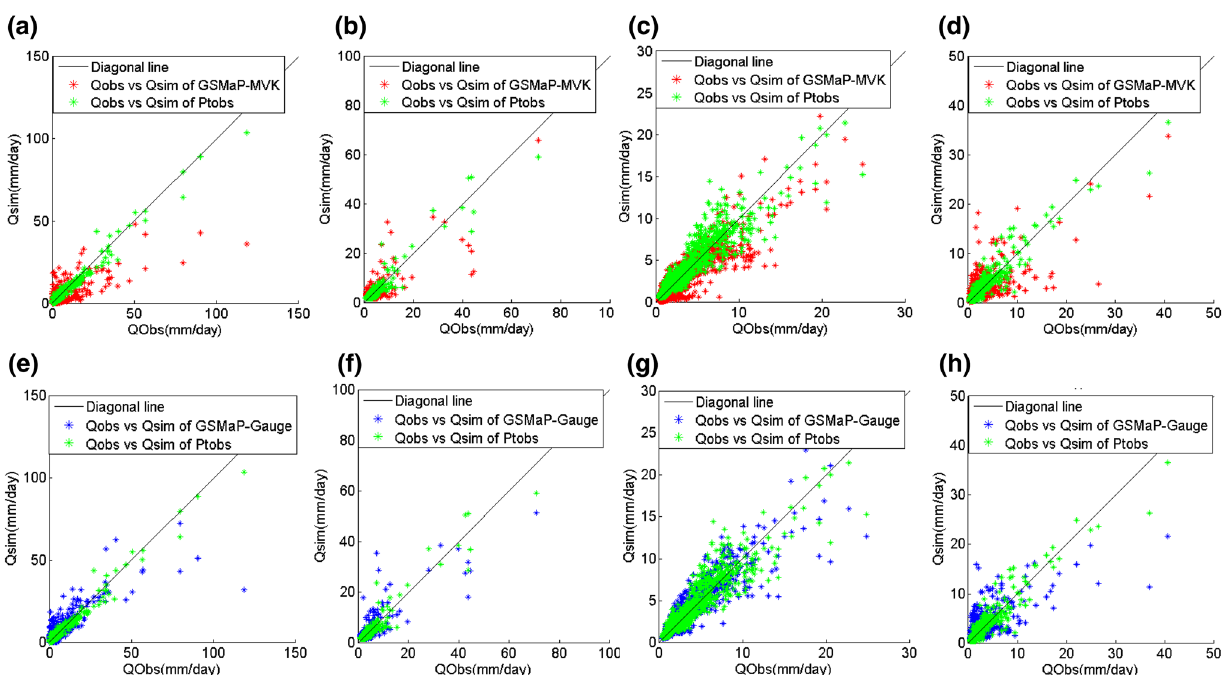
Fig. 13 Scatter plots between observed discharge and simulation discharge by rain gauge (green star) vs GSMaP-MVK (red star) and vs GSMaP- Gauge in a , e Hyeonsan, b , f Fuji, c , g Da and d , h Upper-Cau during the simulation